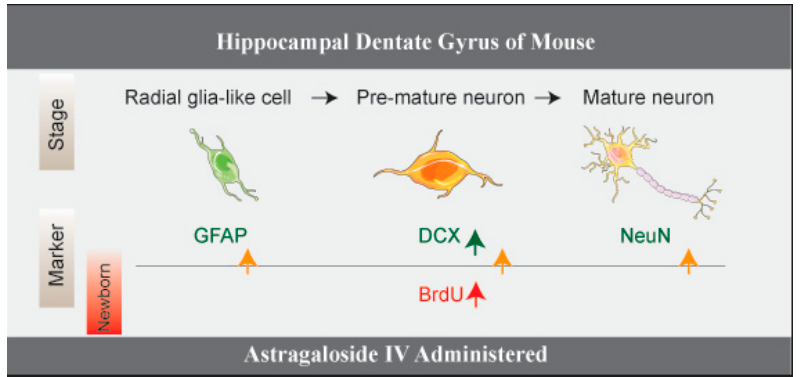
Figure 4. The schematic illustration of the promotive effect of ASI (25 mg/kg) on adult neurogenesis in DGs.